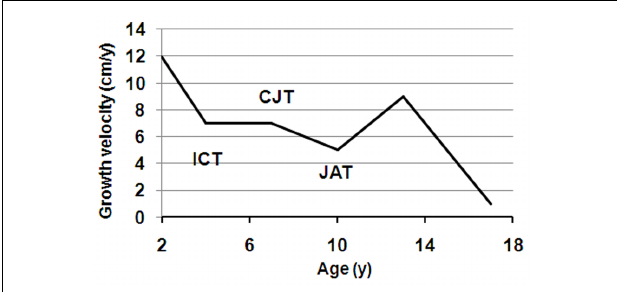
FIGURE 1 | Growth during pre-adult life history stages. The 50th percentile of first derivatives for both boys (solid line) and girls (dashed line) were calculated from the US CDC (2000) data.The upper part indicates the four pre-adult life history stages: infancy (I), childhood (C), juvenility (J), and adolescence (A).The three transition points are marked by a circle, and designated as ICT, infancy–childhood transition; CJT, childhood–juvenility transition; JAT, juvenility–adolescence